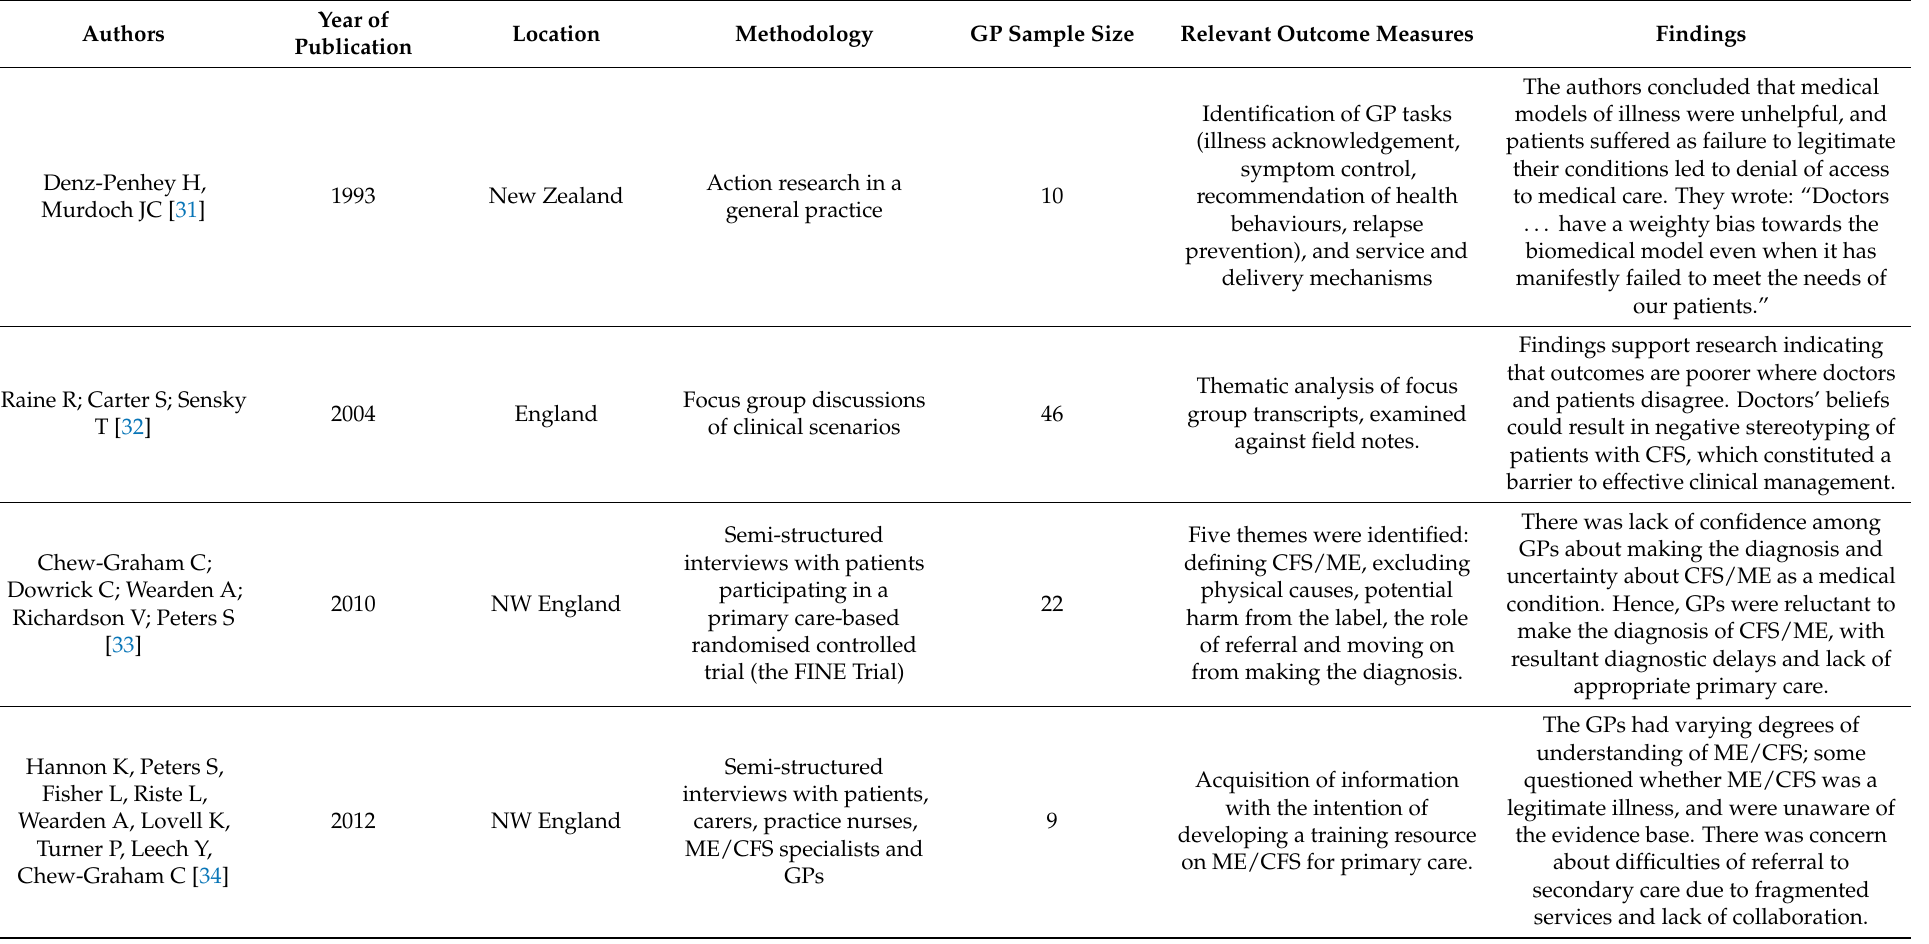
Table 6. Papers reporting qualitative studies of GPs’ knowledge and understanding of